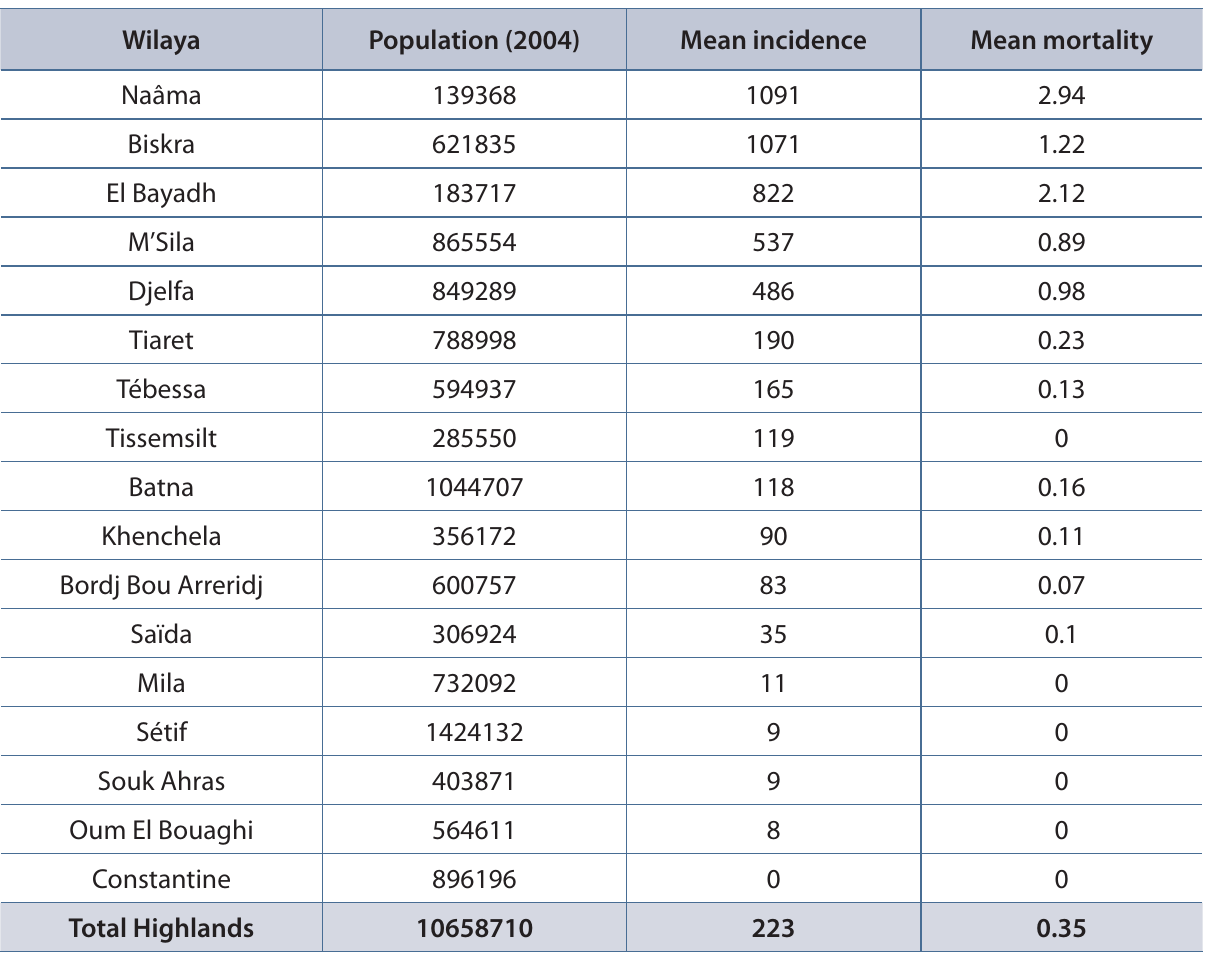
Table 3. Incidence and mortality in the Highlands (2001-2010) Wilaya